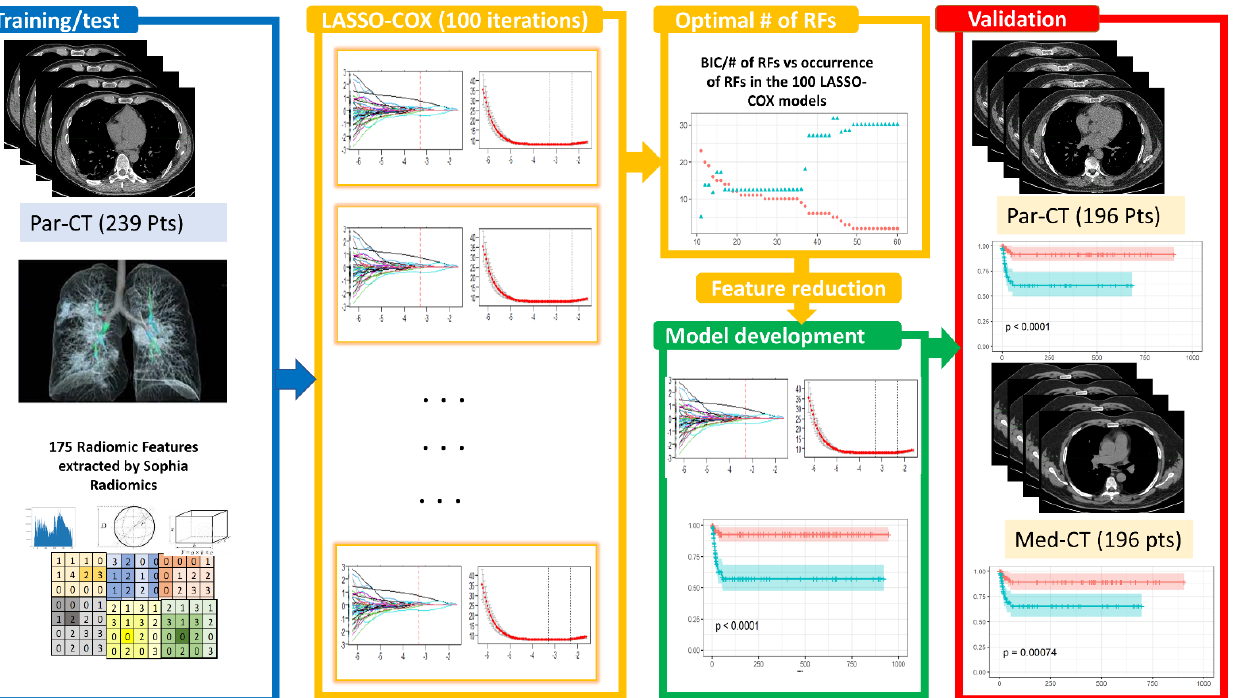
Figure 1. Study design relies on the following steps: [1] identification of a dataset of 239 patients with high-resolution CT (Par-CT), grouped into training and test sets following a stratified 70/30 split, iterating the process 100 times. These datasets were used for the 100 LASSO-Cox feature selection. The optimal number of RFs for inclusion in developing the LASSO-Cox model was determined using the BIC values. The final model was validated using a dataset of 196 having high and standard CT reconstruction (Par-CT and Med-CT, respectively). In all the datasets, 175 RFs were extracted using SOPHiA DDM.